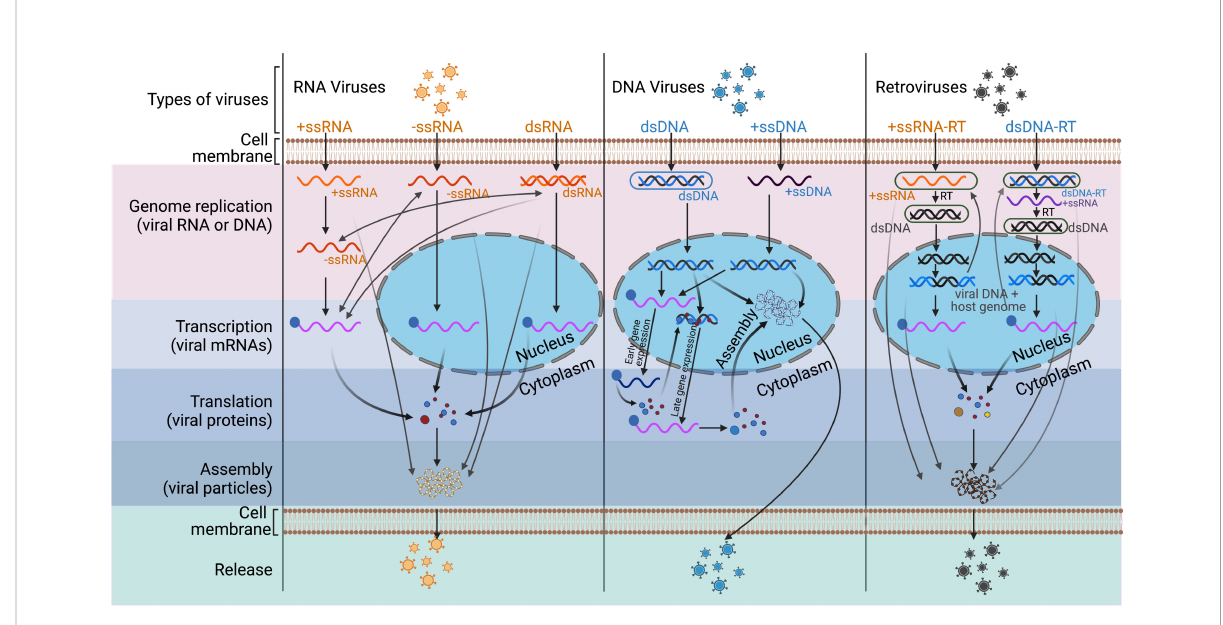
FIGURE 2 Life cycles of RNA viruses, DNA viruses, and retroviruses. This diagram illustrates the steps of the viral life cycle of different types of viruses. Further, unlike RNA or retroviruses, DNA viruses have a different replication compartment within the nucleus or cytoplasm, as described in (38). +ssRNA (CVB, DENV, EMCV, EV-A71, FMDV, HAV, HCV, HEV, HRV, JEV, MHV, PEDV, PRRSV, PV, SARS-CoV-2, SINV, SVV, TGEV, WNV), -ssRNA (BDV, BEFV, EBOV, IAV, JUNV, NDV, NiV, RABV, VSV), dsRNA (ARV), ssDNA (PPV), dsDNA (EBV, HCMV, HPV, HSV, KSHV), ssRNA-RT (HIV, HTLV, RSV), and dsDNA-RT (HBV) viruses are featured in this review. See text for details. RT, reverse transcriptase. The image was created with